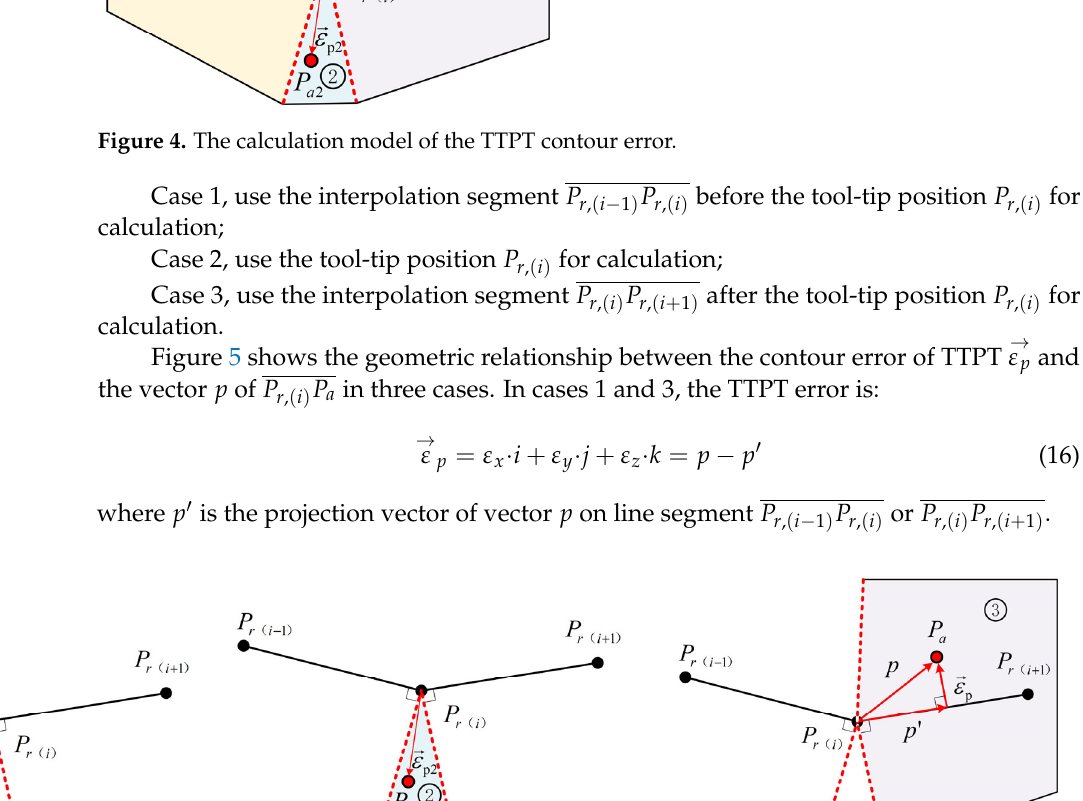
Figure 5. The geometric relationship between p  ( b ) Case 2; ( c ) Case